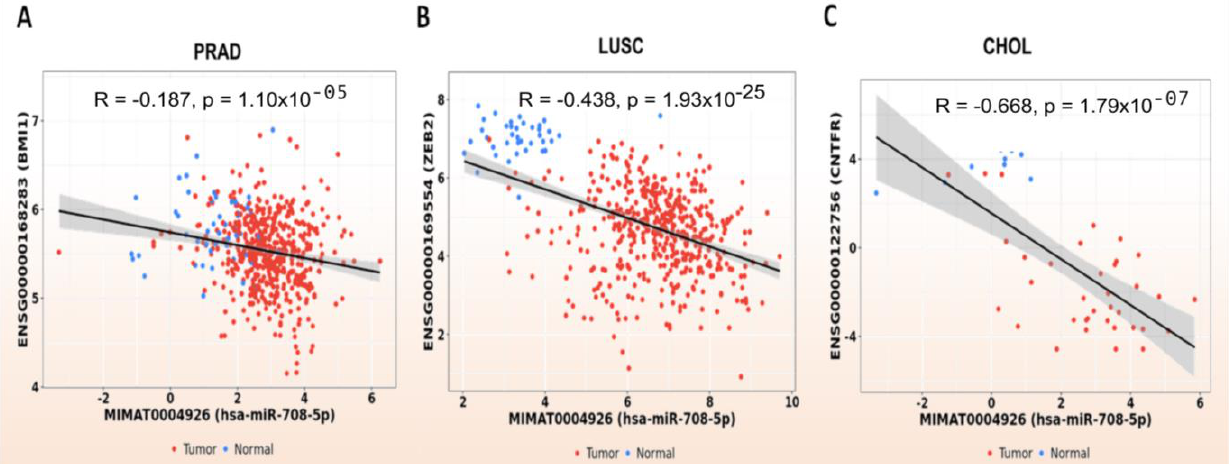
Figure 8. ( A – C ) BMI1, ZEB2 and CNTFR, and miR-708-5p Pearson´s correlation plots for PRAD, LUSC, and CHOL cohorts, respectively. The correlation plots were only generated for negative correlations with a p value < 0.05. For other interactions refer to Supplementary Table S2.